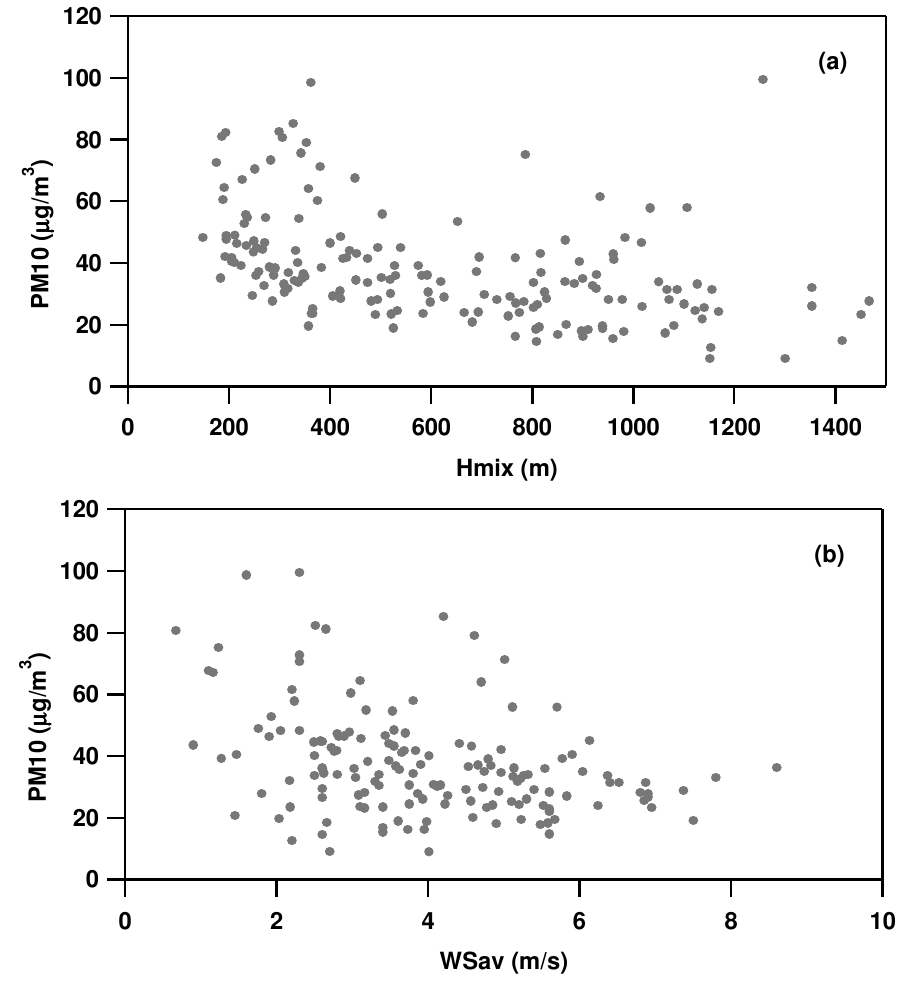
Figure 11. Scatterplot of PM10 mass concentrations versus (a) mixing layer height mean values (Hmix) and (b) wind speed mean values (WSav) for Arnesano and 2006-year data.